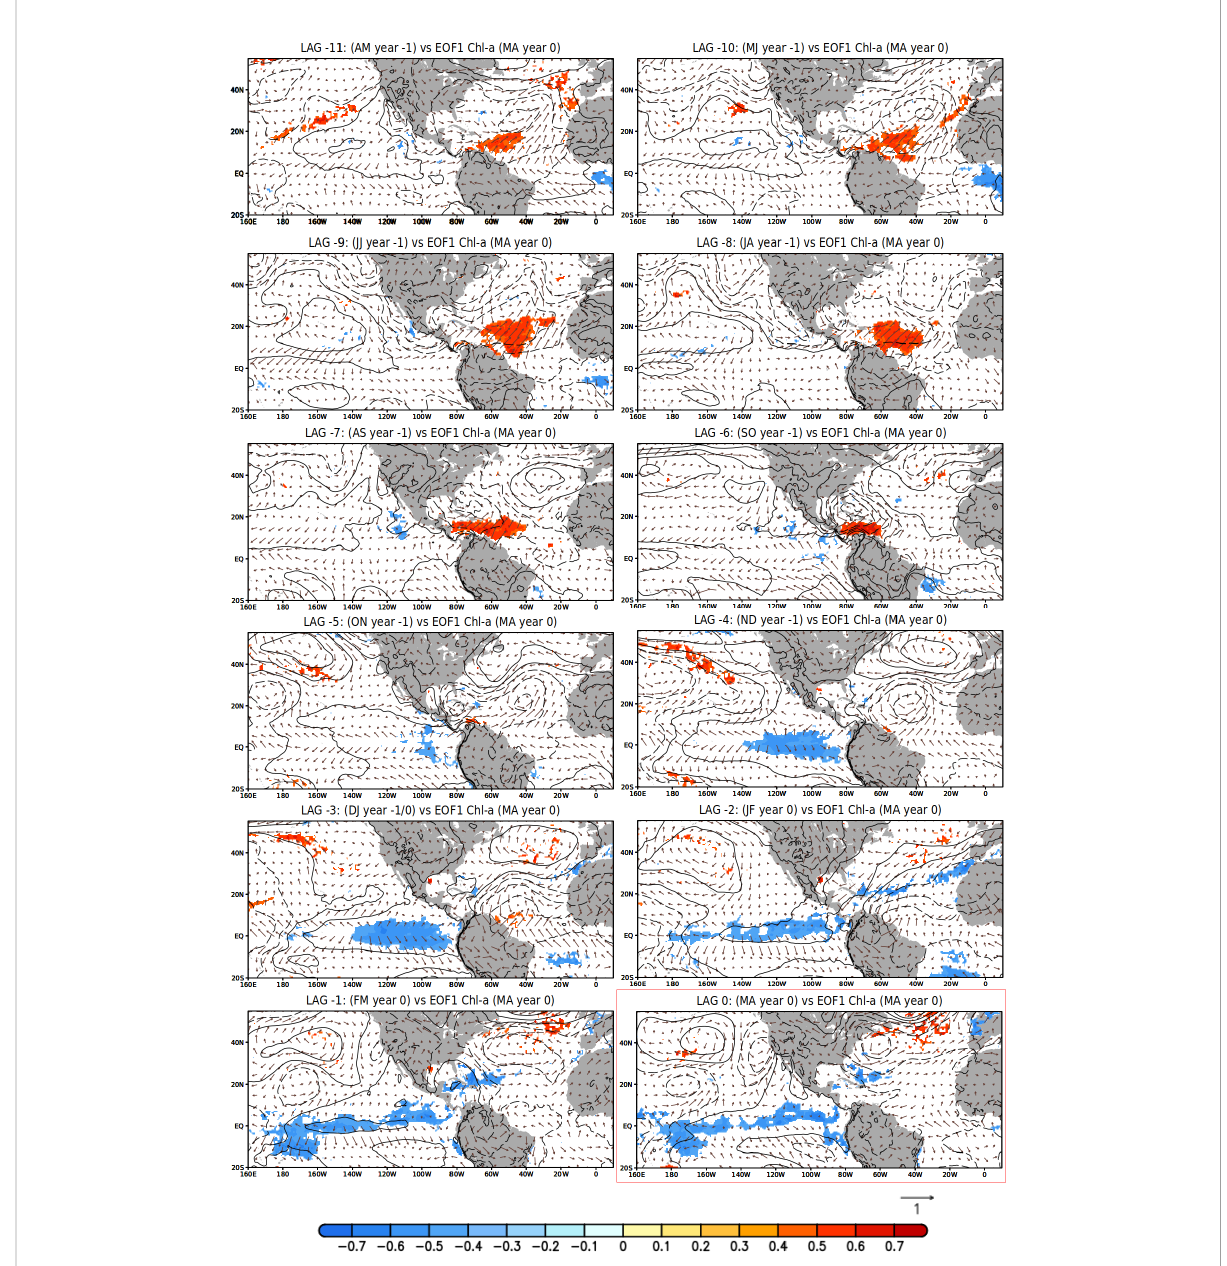
FIGURE 4 Regression maps, at different lags, of the Chl-a variability mode calculated in March – April and within the nAS (PC1; see Figure 2C), onto 1) SST anomalies (shaded; units in degrees), 2) sea level pressure anomalies (contoured with ci = 0.1 Pa ; positive values in solid lines and negative values in dashed lines), and 3) surface wind anomalies (vectors; unit in m/s). From top-left to bottom-right panels, the responses from April to March of the previous year (lag -11) to March – April of year 0 (lag 0; highlighted in red). The corresponding lag is shown on top of each panel. Only those SST anomalies which are statistically signi fi cant (p-values less than 0.05) based on a Student t-test are